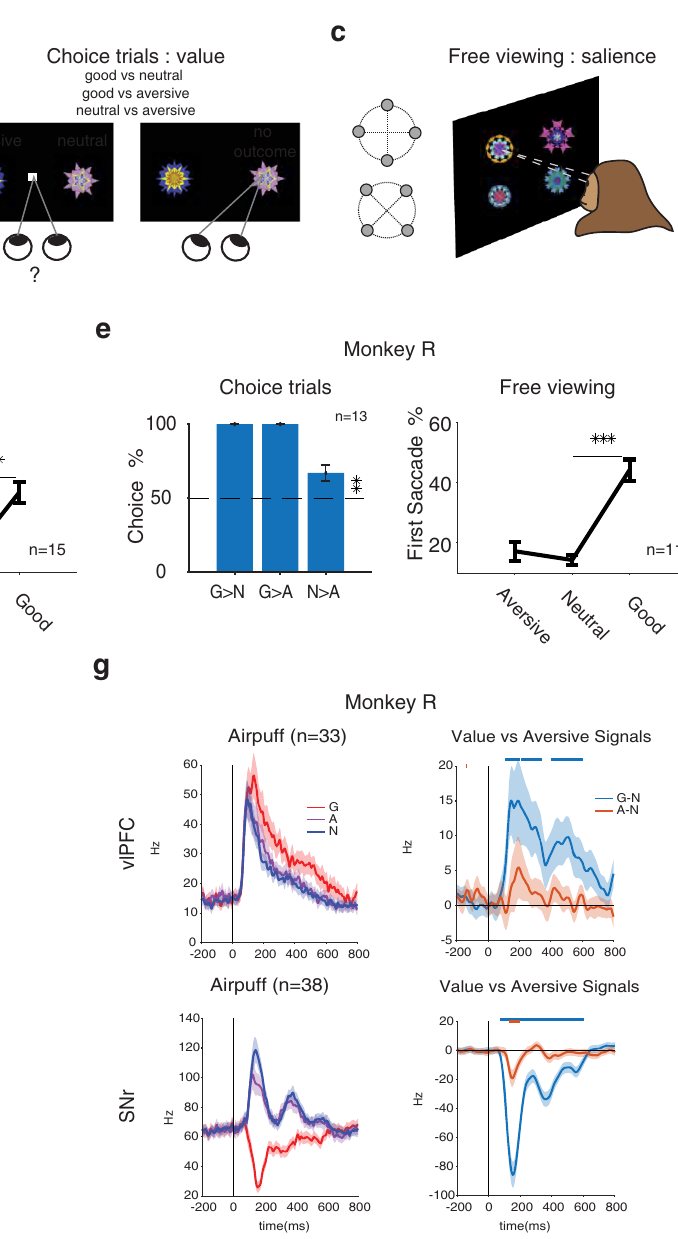
Fig. 2 | Responses of vlPFC and cdlSNr to airpuff associated objects code their positivesalienceratherthantheirnegativevalence.a Theairpuffsetsconsisted of 2 objects with large reward (good objects) and 2 objects with airpuff (aversive objects) associations and 4 objects with no outcome (neutral). b Measuring valence: choice trials in which monkey denoted preference by saccading to and holdinggazeononeobjectamongtwoandreceivedtheassociatedoutcomeorno- outcome depending on the object category. Multiple saccades were allowed. c Measuring salience: free viewing trials in which 4 objects were randomly chosen fromgood,aversiveandneutralcategoriesandweredisplayedforfreegazewithno outcome. d , e Average choice and free viewing performance for each monkey across sessions. Choice trial performance are separately shown for choosing good more than neutral (G>N), good more than aversive (G>A) and neutral more than